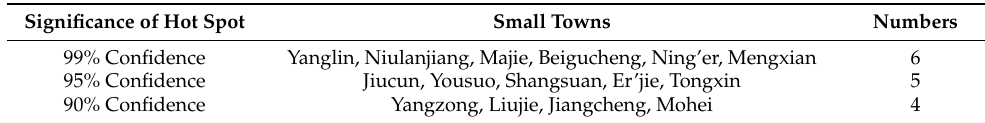
Table 10. Cluster results of integrated